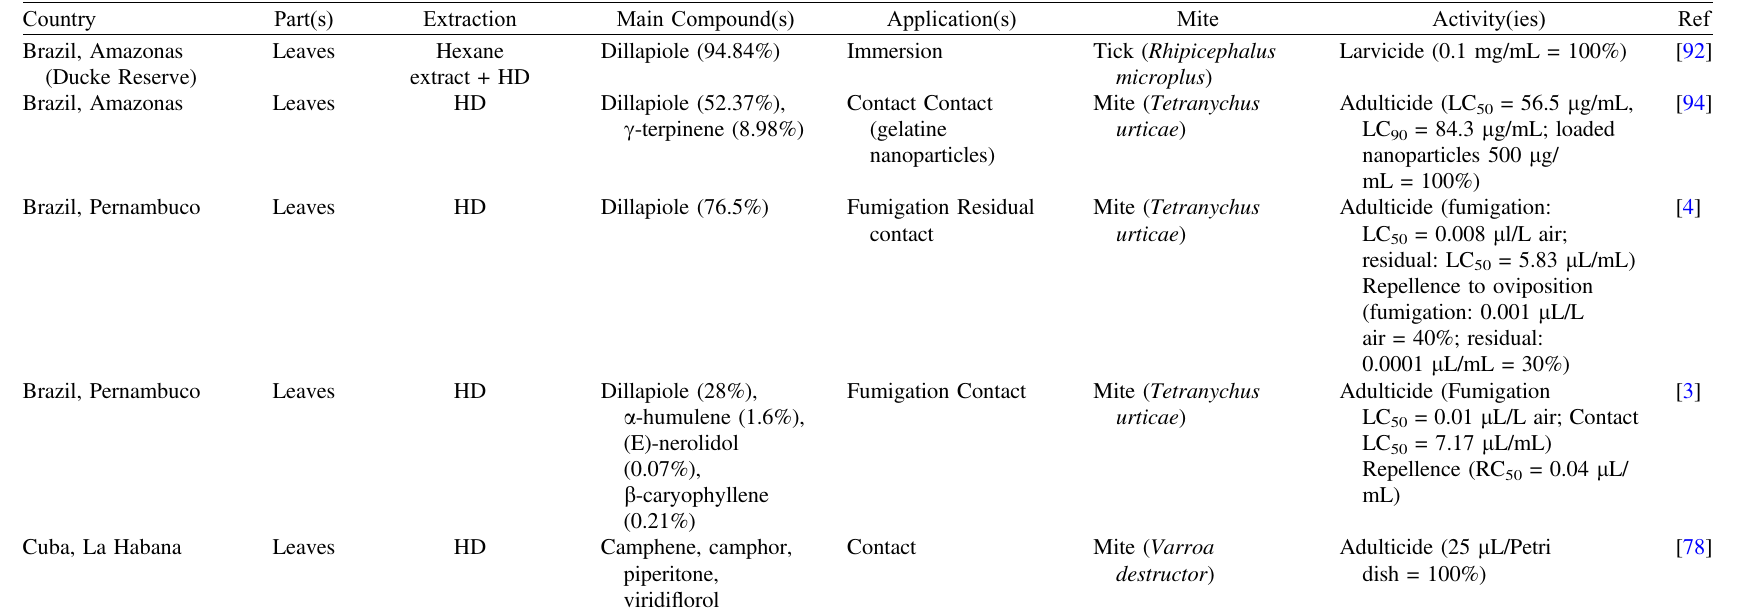
Table 3. Acaricidal activity.